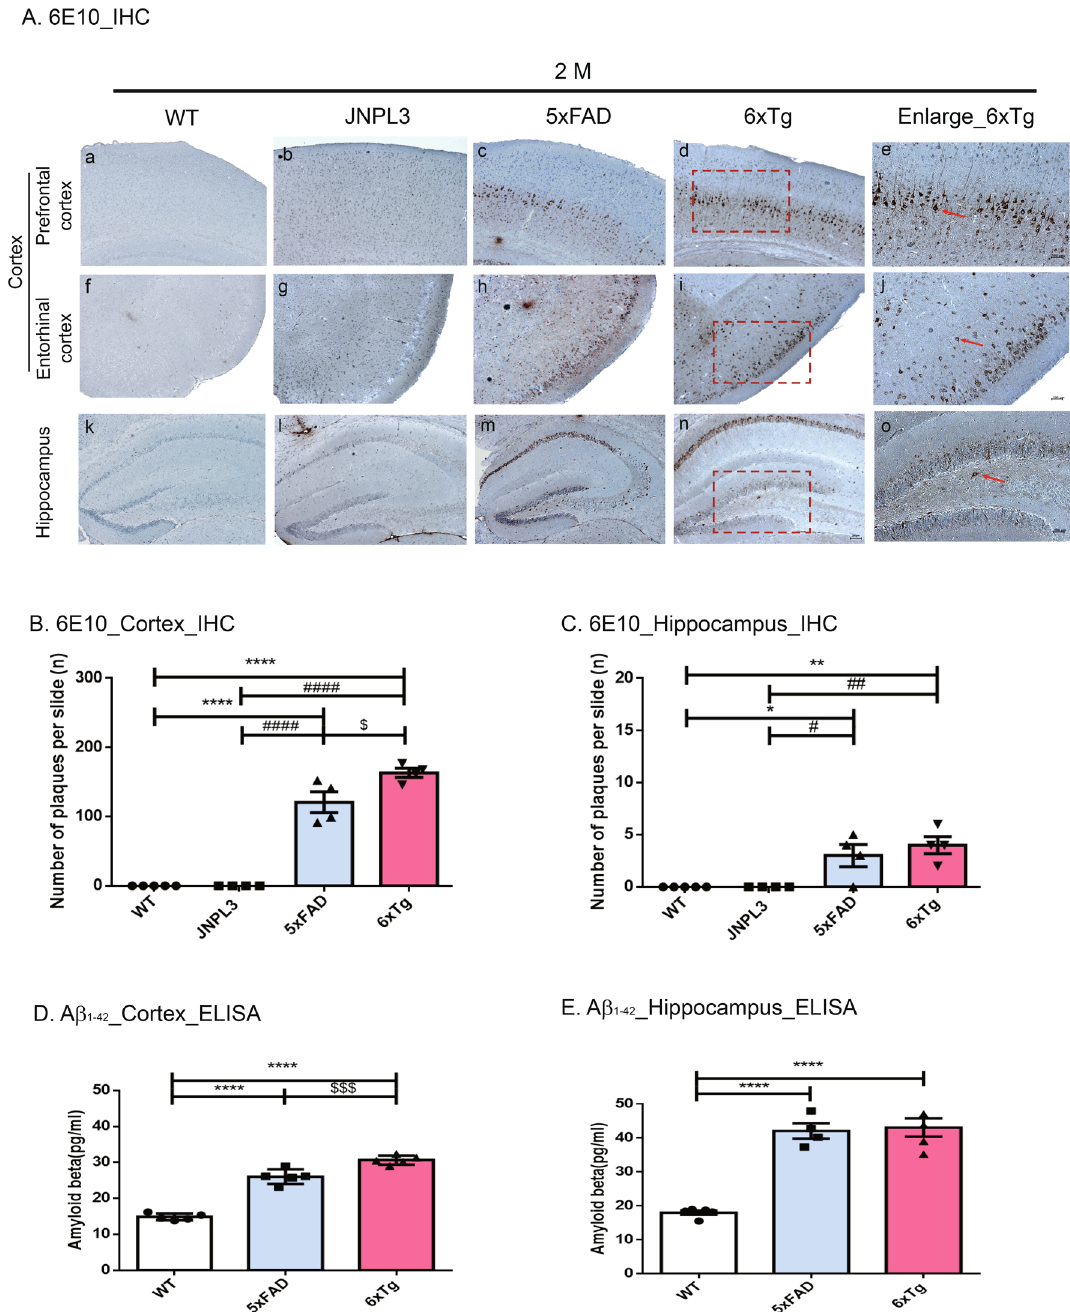
Figure 2. Age-dependent increase of Aβ plaques and amount of Aβ in the brains of 6xTg mice. ( A ) Immunohistological staining of amyloid plaques and tau phosphorylation with anti-Aß (6E10) in the cortex [prefrontal cortex ( a – d ) and entorhinal cortex ( f – i )] and hippocampal dentate gyrus (k–n) of 2-month-old 6xTg mice and their age- and gender-matched WT, 5xFAD, and 6xTg littermates. Scale bar 200 μm. The red box contains enlarged images of cortical and hippocampal regions of 6xTg mice (e, j, o; Scale bar 100 μm). Red arrow-shaped 6E10-positive neurons were counted. ( B , C ) In the 6xTg mice, the number of plaques was significantly increased compared with WT mice, but Aß deposition showed no significant difference compared with the 5xFAD mice, but showed a tendency to increase in the hippocampus. ( D , E ) Aß proteins from cortical and hippocampal brain lysates of mice were subjected to ELISA assay and levels of Aß were examined. All data are given as means ± SEM (n = 5 mice per group). Statistical analyses were performed by one-way ANOVA followed by the Tukey’s multiple comparisons test. **** p < 0.0001, *** p < 0.001, ** p < 0.01 vs, * p < 0.05 vs. WT; #### p < 0.0001, ### p < 0.001, ## p < 0.01, # p < 0.05 vs. JNPL3; $$$ p < 0.001 vs, $ p < 0.05 vs.